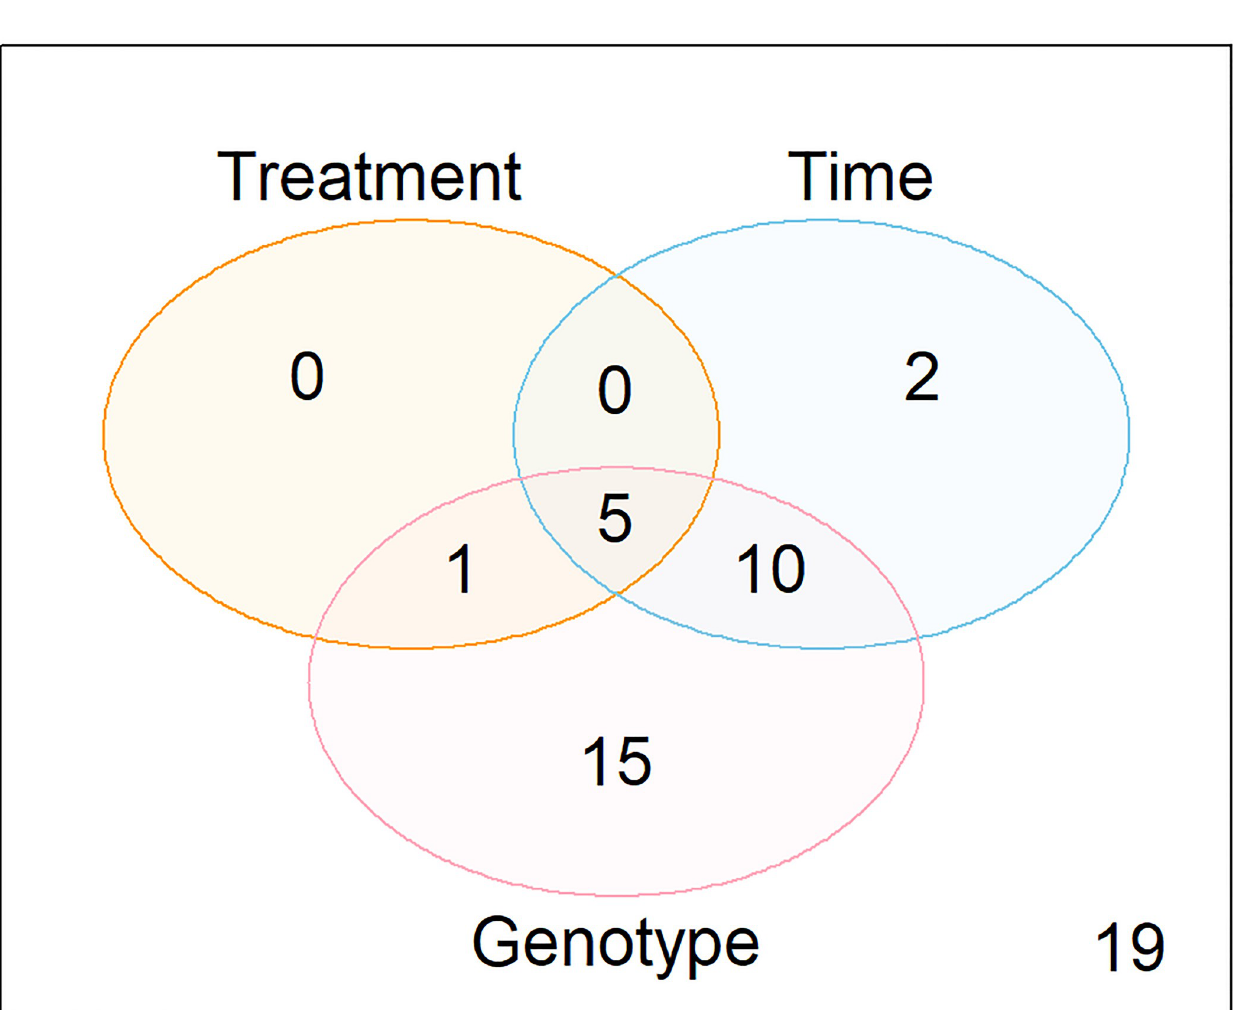
Fig 4. Overlaps between the peaks significantly associated with treatment, time, and genotype at times T1-T2. Significance was defined as Bonferroni- adjusted p-value < 0.05 for 6,334 peaks. The peaks considered at times T1-T2 were out of the 52 peaks considered, consisting of the top 50 peaks most significantly associated with genotype at T0, plus creatine and creatinine. 19 peaks were not significantly associated with treatment, time, or genotype (bottom right